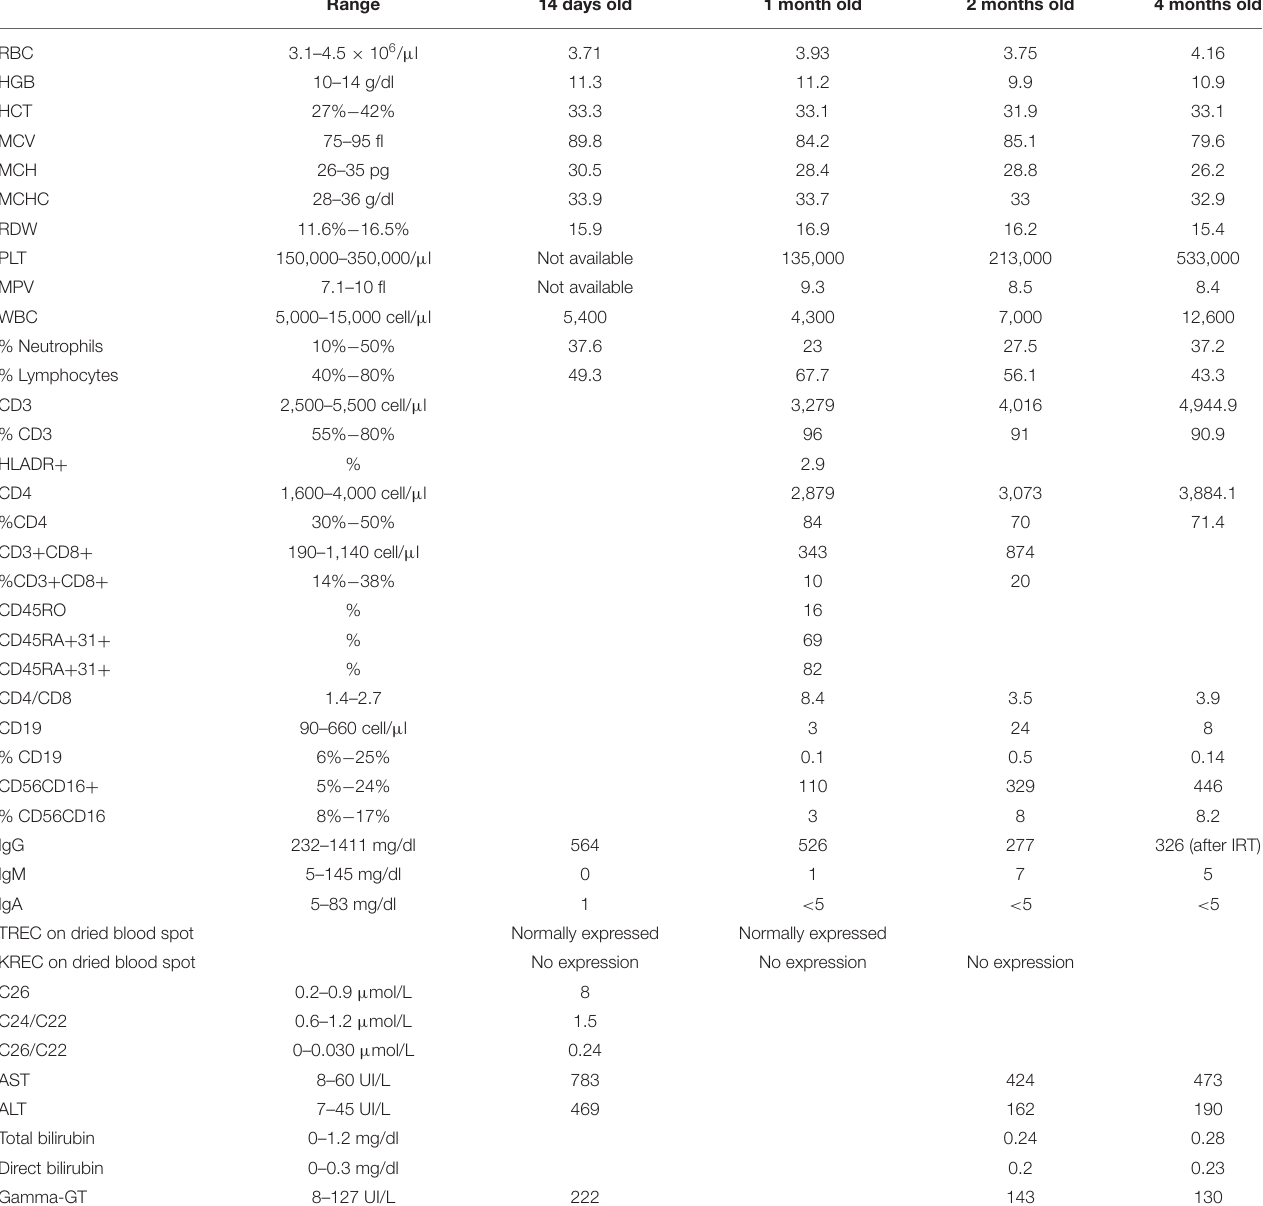
TABLE 1 | Patient’s biochemical, hematological, and immunological data from birth until 3 months old.